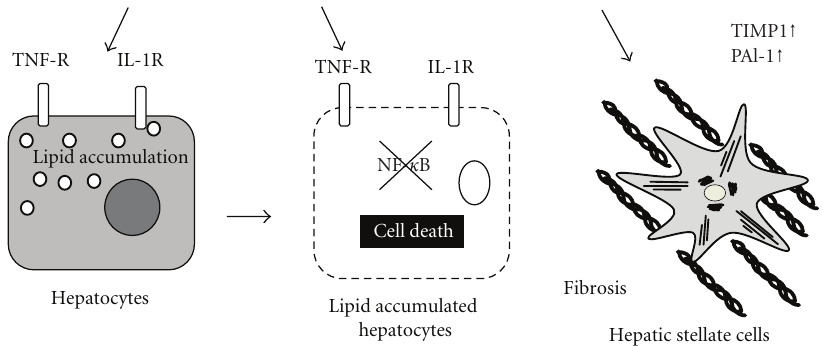
Figure 1: TLRs and downstream signaling in NAFLD. Kup ff er cells respond to TLR ligands such as LPS and bacterial DNA through TLR4 and TLR9, respectively. Upon TLR ligation, MyD88, an adaptor molecule, is recruited to transmit the signals that activate NF- κ B and JNK. Activated Kup ff er cells produce inflammatory cytokines such as TNF α and IL-1 β and chemokines such as MCP-1 (CCL2). These inflammatory cytokines and chemokines induce lipid accumulation in hepatocytes and cell death. In addition, TNF α and IL-1 β promote liver fibrosis by activating hepatic stellate cells. Other cells including hepatic resident cells, infiltrated cells into the liver, and adipose tissue macrophages produce various mediators in response to TLR ligands. These pathways also contribute to the development of